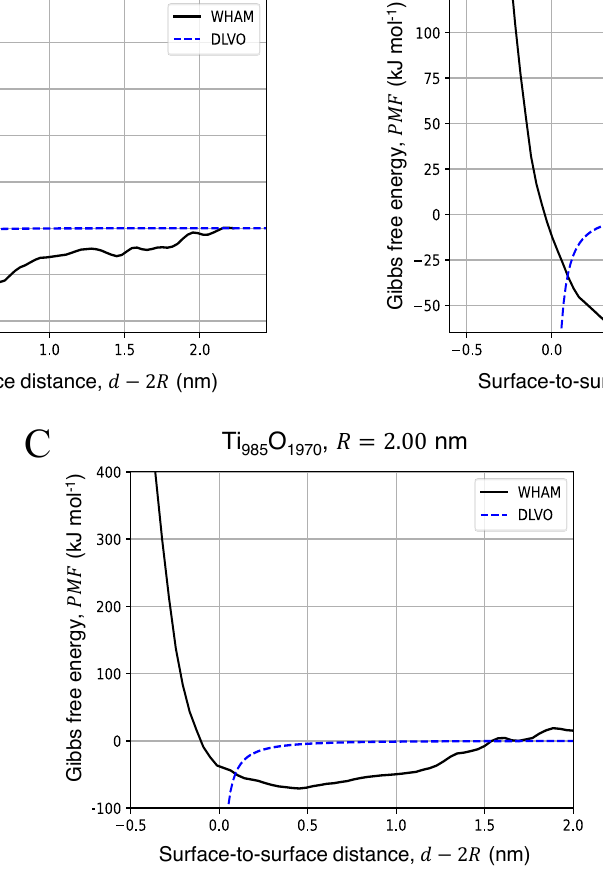
Figure 6. Comparison between the classic DLVO theory (dashed blue line), evaluated through Equation (7), and the PMF evaluated obtained by WHAM procedure (solid black line) for a pair of ( A ) Ti O NPs, ( B ) a pair of Ti 111 222